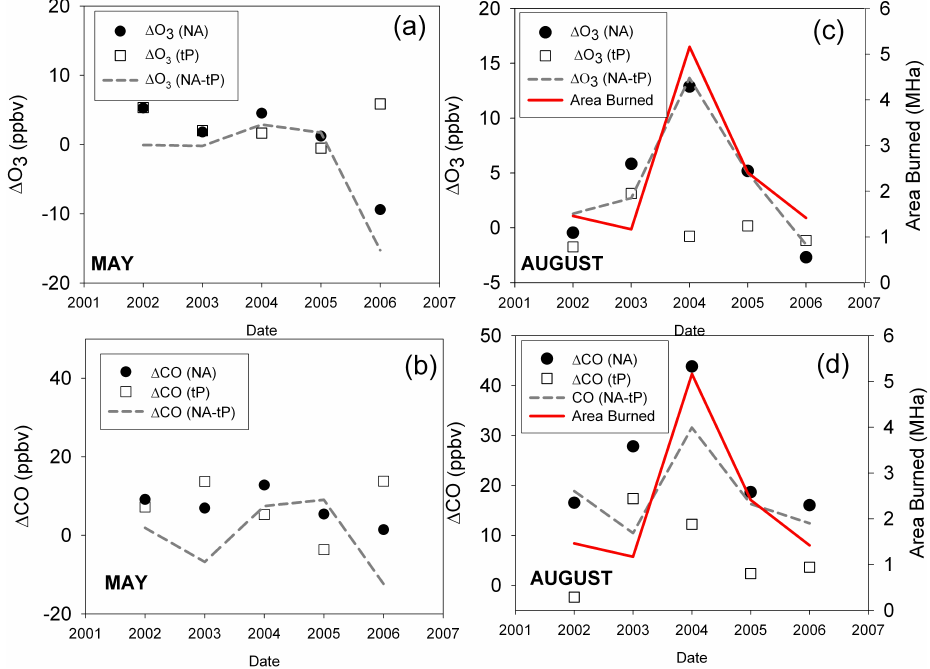
Fig. 8. (a) Mean O 3 mixing ratios in North American and in trans-Pacific boxes minus the clean Pacific background in May 2002–2006. The dashed line shows the difference between NA and t-P O 3 ; (b) as in Fig. 8a but for CO; (c) as in (a) but shows 1 O 3 for August; (d) as in (c) but shows 1 CO for August. The red line shows the sum of western North America area burned as reported in Table 2. Table 1. Estimates of area burned in western North America and for the Russian Federation for 2002-2006. (Sources: US National Interagency Fire Center; Canadian Interagency Forest Fire Centre; Goldammer et al., 2007). British Yukon North West Alberta Alaska US Northwest 1 US Northern Russian Columbia Territory Territories Rockies 2 Federation Ha